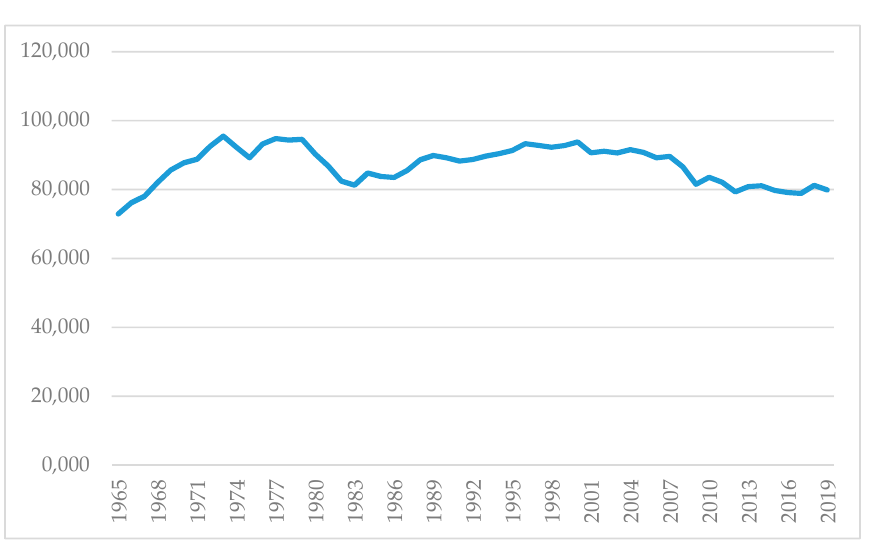
Figure 8. Energy consumption per capita (kWh) in the U.S.A. (according to the data source